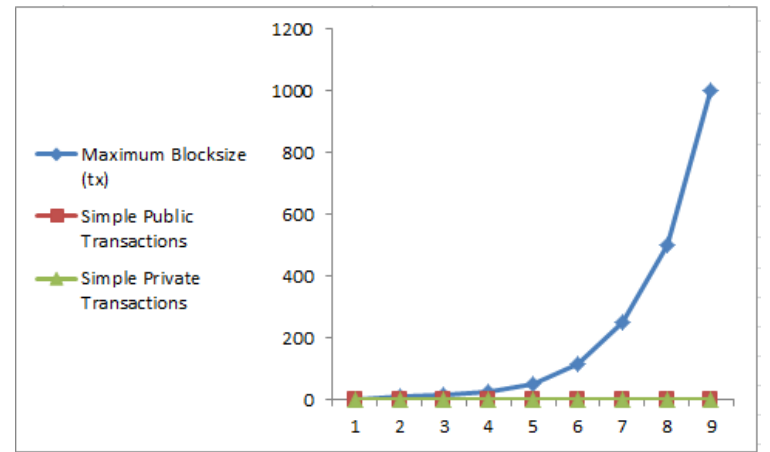
Figure 25. Latency at low throughput vs. block